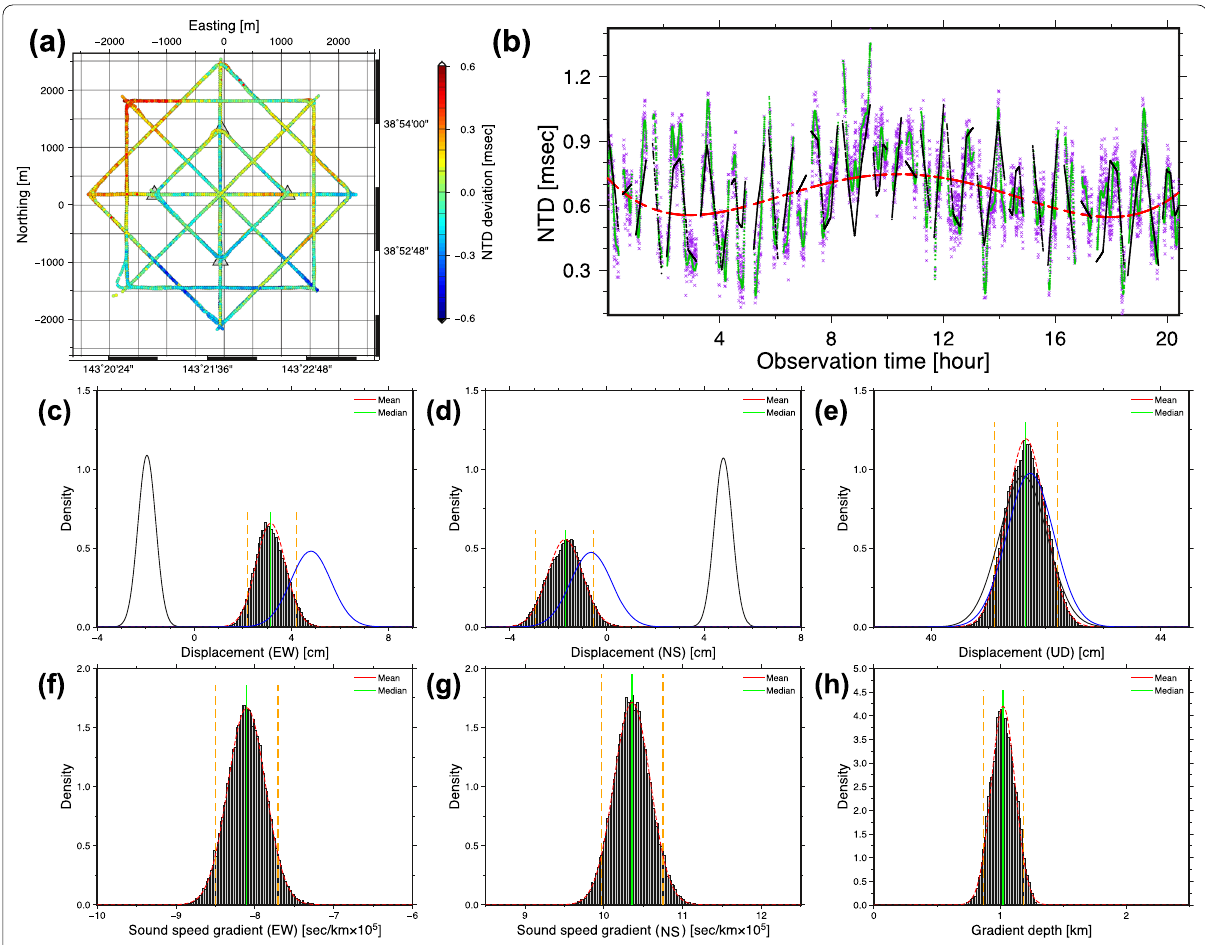
Fig. 4 Estimation results of Method-3 at KAMN on August 1, 2014. a Sea-surface platform positions when the acoustic signals were transmitted. The colors show NTDs subtracting the long-term fluctuation of NTDs estimated by Model-3. b NTD time-series. Purple plots show temporal fluctuation of NTD, the green curve shows the NTD modeled by the 3d B-spline functions, the red curve shows the long-term fluctuation of NTD modeled by the 4d polynomial function, and a black curve shows the NTD modeled by the long-term fluctuation and the shallow sound speed gradient. c – h posterior PDFs for the major unknown parameters: gray histograms demonstrate the PDFs obtained by Method-3, red curves show the Gaussian distributions equivalent to the PDFs of Method-3, black curves in c – e show the Gaussian distributions for the parameters estimated by Method-1, and blue curves in c – e show the Gaussian distributions for the parameters estimated by Method-2. The red, green, and orange vertical lines represent mean, median, and 95% credible